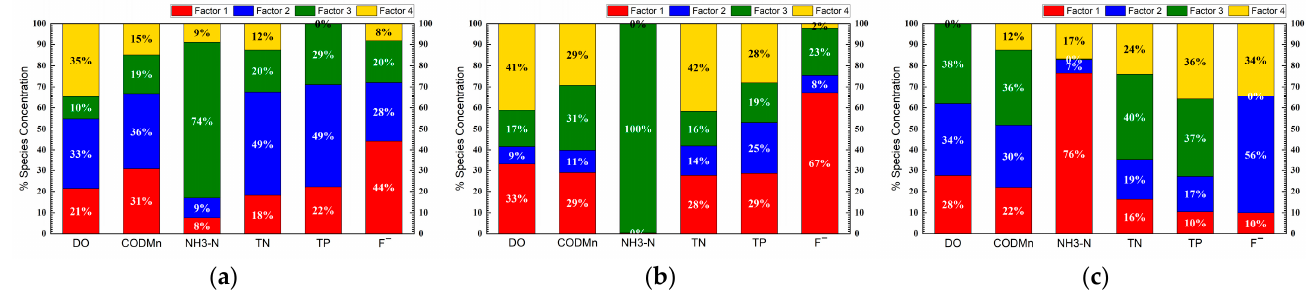
Figure 11. Factor figure prints resulting from PMF model. ( a ) Upstream, ( b ) Midstream, ( c ) Downstream. Table 10. Pollution factors matching in upstream, midstream, and downstream.